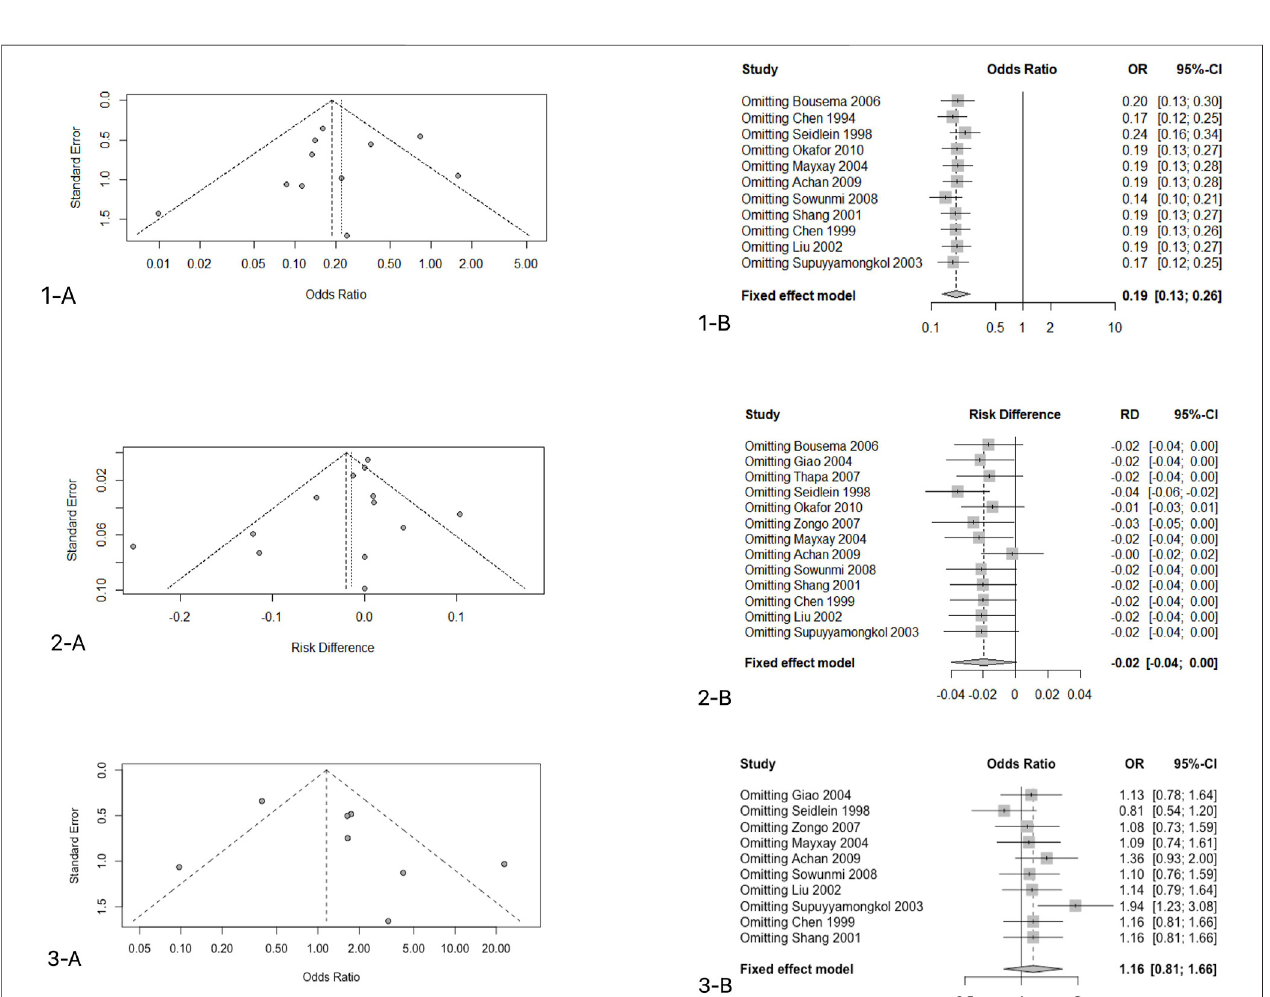
FIGURE 5 | Research publication bias and sensitivity analyses.